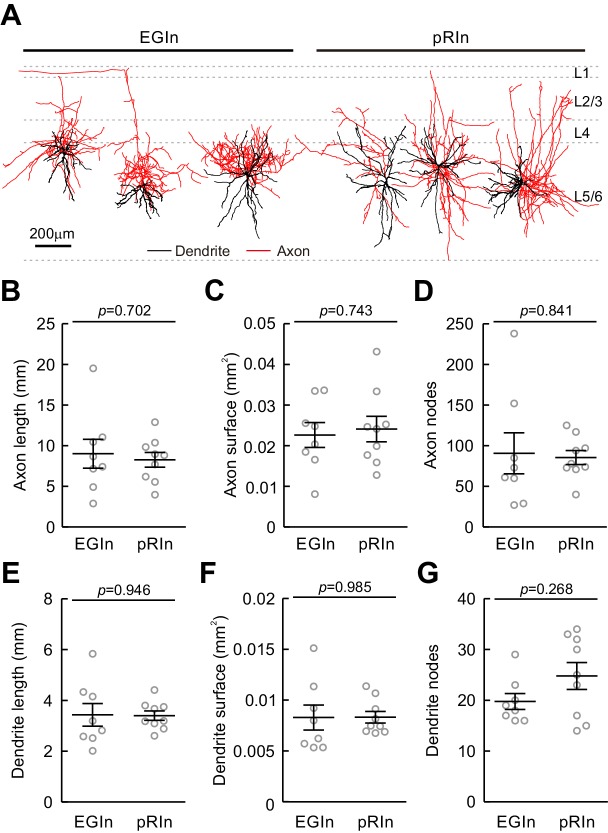
Morphological properties of EGIns and pRIns at P15–20.(A) Morphological samples of EGIns (left 3 cells) and pRIns (right 3 cells) from layer 5/6 of the somatosensory cortex. Scale bar, 200 μm. (B–G) Comparison of axon length (B), axon surface (C), axon nodes (D), dendrite length (E), dendrite surface (F) and dendrite nodes (G) between EGIns and pRIns. Detailed statistical analysis, detailed data and exact sample numbers are presented in the Figure 2—source data 1. Error bars indicate mean ± SEM.